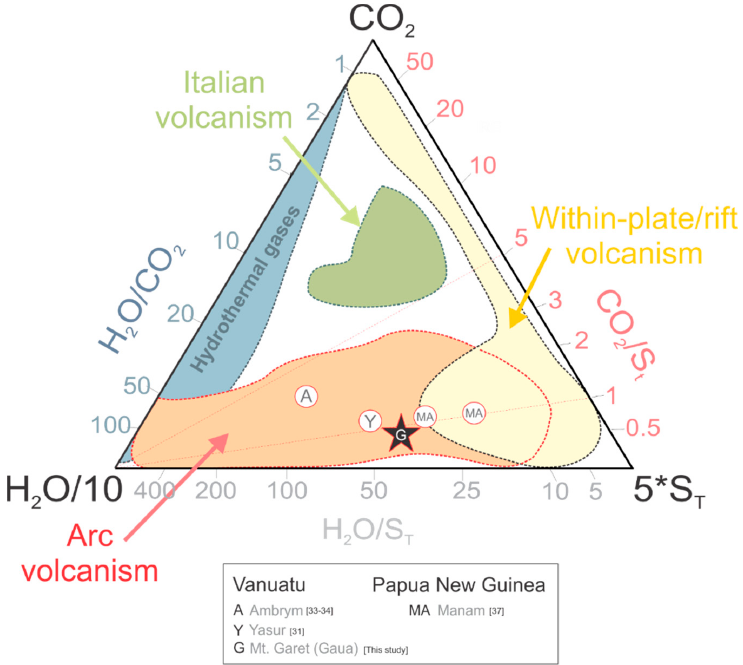
Figure 5. H 2 O–CO 2 –S T (S T = SO 2 + H 2 S) ternary plot with gas composition for Mount Garet volcano